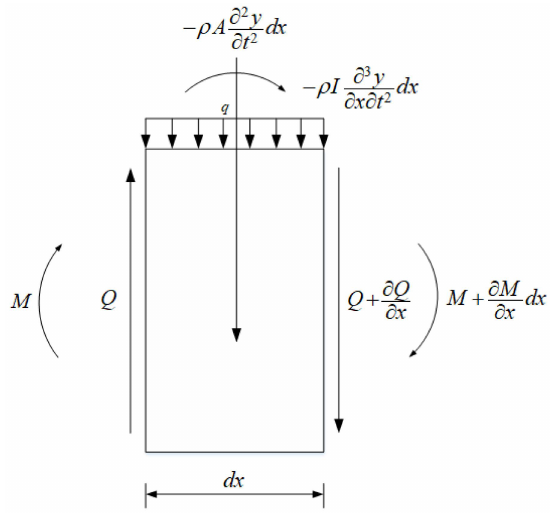
Figure 2. Free body diagram for a di ff erential